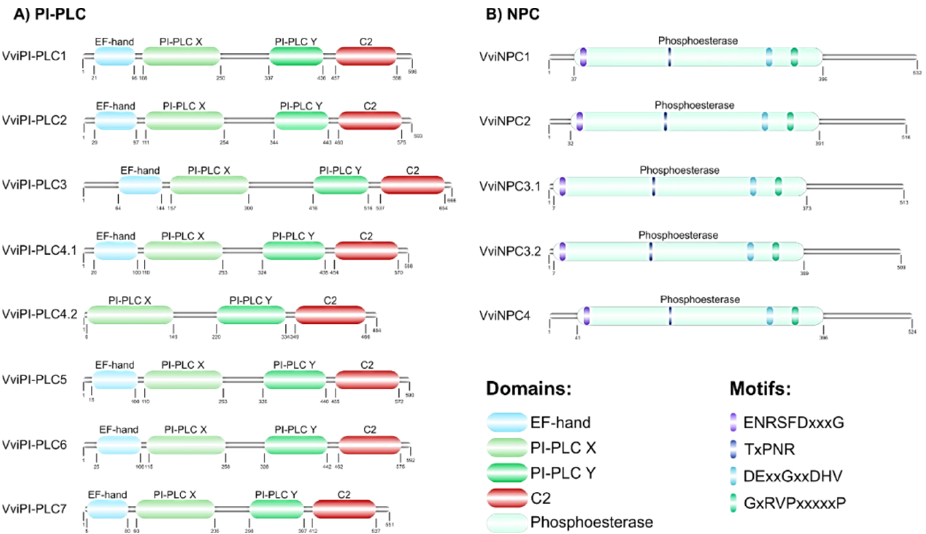
Figure 3. Peptide domain structures and conserved motifs of grapevine PLC members. Schematic diagram representing: ( A ) PI-PLC and ( B ) NPC groups. Different motifs and domains are indicated by different